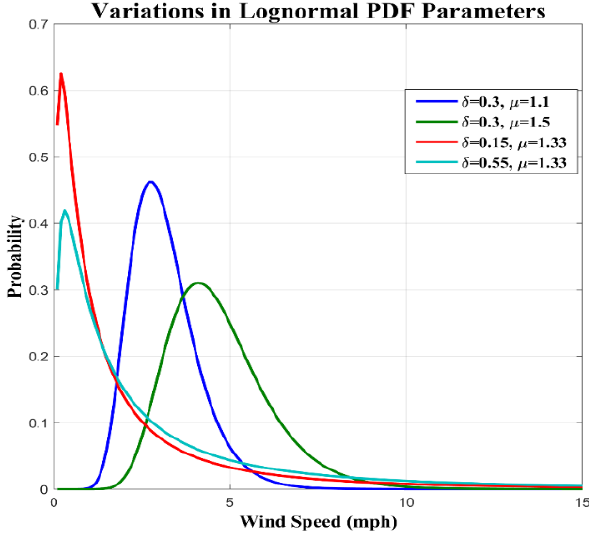
Figure 11. Wind speed curve fitting of different PDF-s.